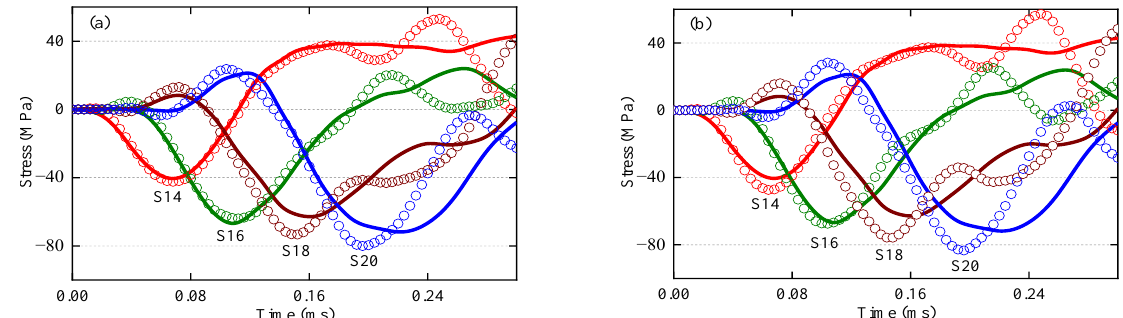
Figure 9. Stress responses of the 91st impact ( H = 360 mm): ( a ) Experimental results (Solid line) and eigenfunction method results (Scatter symbols) with KE model; ( b ) Experimental results (Solid line) and eigenfunction method results (Scatter symbols) with KK model.